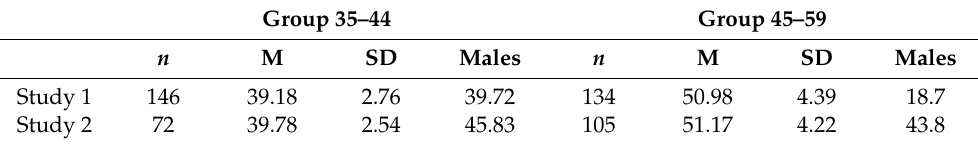
Table 1. Demographic data for age groups in Study 1 and Study